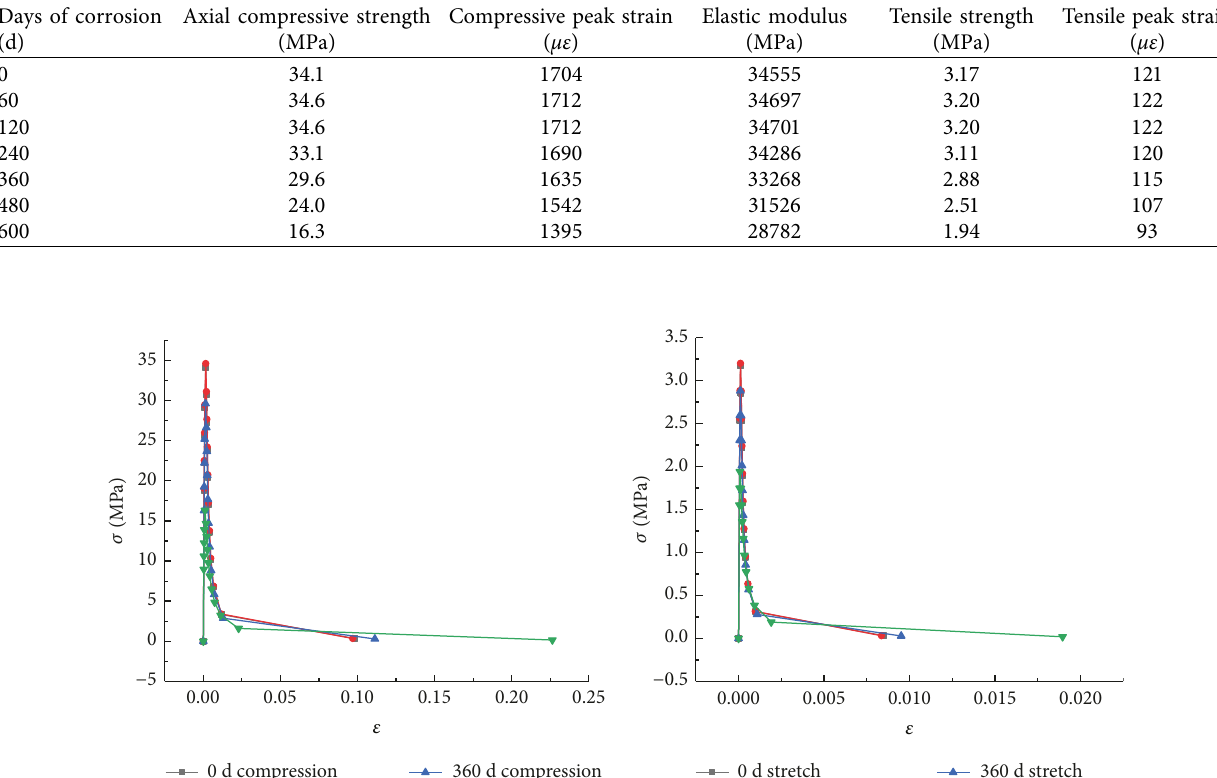
Table 2: Constitutive parameters of concrete corresponding to corrosion